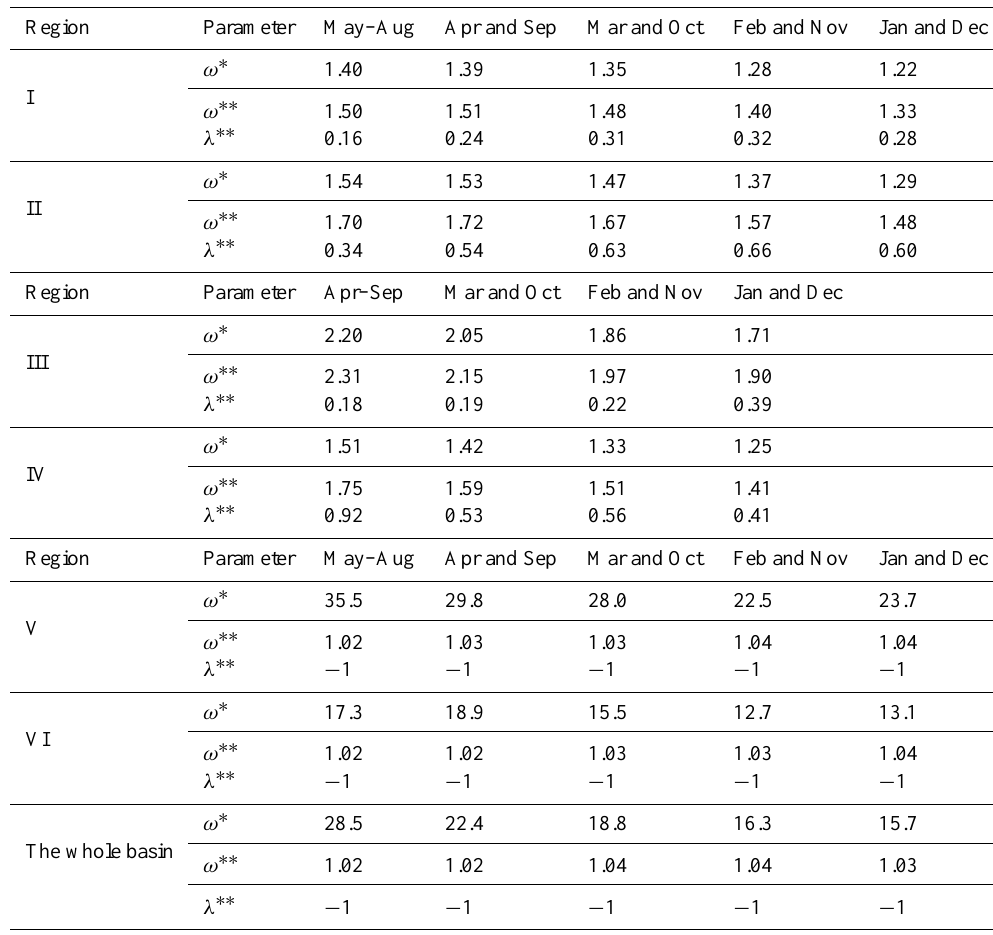
Table 4. The fitting parameters of the improved Budyko equation at the monthly scales.